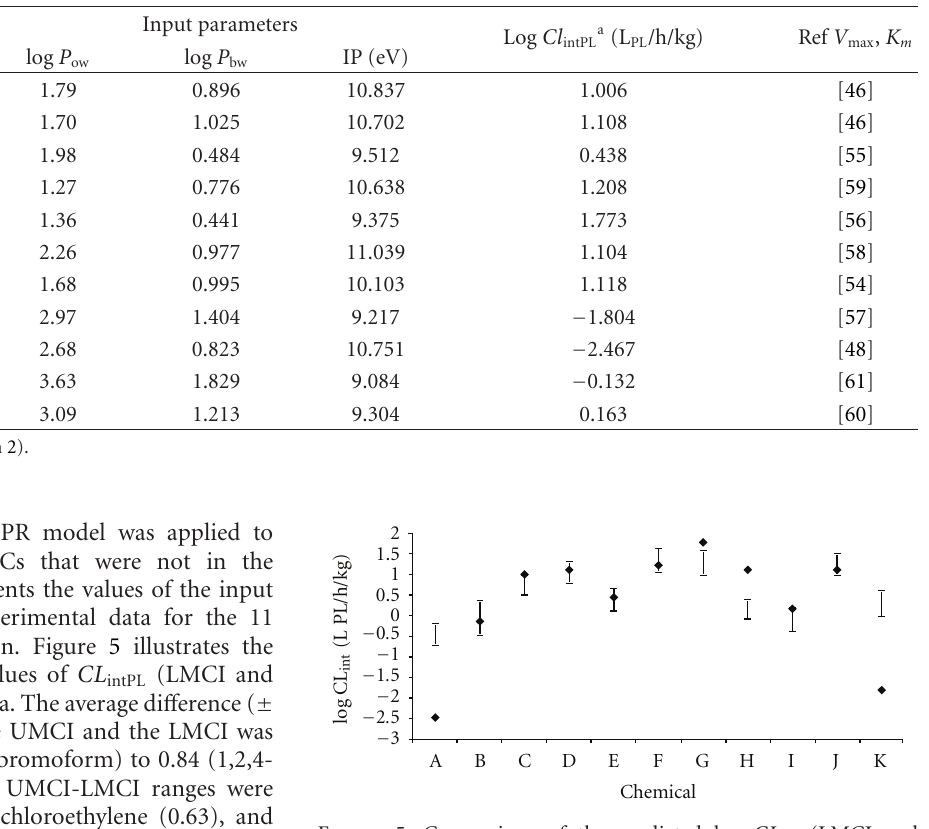
Table 5: Input parameters and experimental data on log CL int for VOCs of QPPR evaluation.